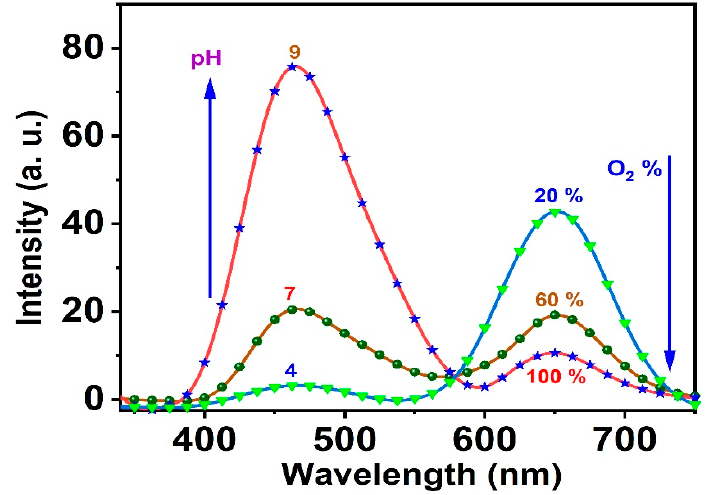
Figure 12. The emission of the ormosil nanosensor at different concentrations of O 2 and pH values under excitation with 365 nm.